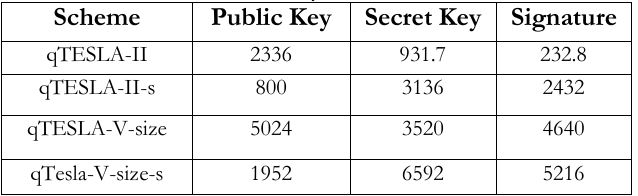
Table 5. Second Round Optimized Implementation Key Sizes in